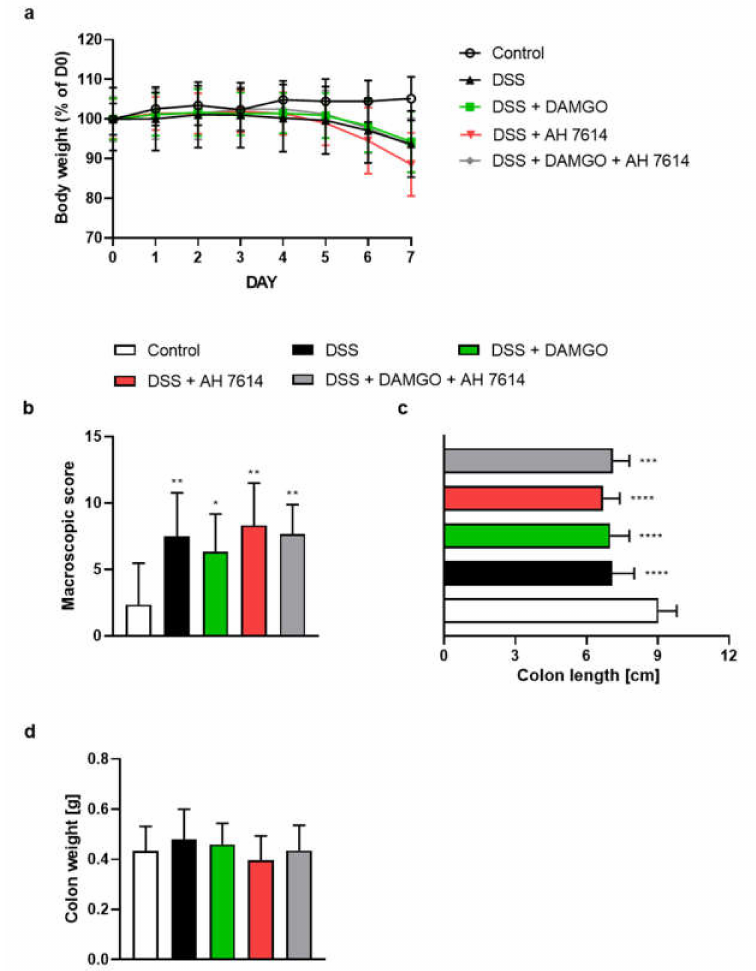
Figure 2. The i.p. administration of MOR agonist DAMGO (0.02 mg/kg BW) and FFAR4 antagonist AH 7614 (1 mg/kg BW) from day 3 to day 6, both twice daily did not alleviate symptoms of DSS- induced colitis in mice. Figure shows data for body weight loss ( a ), macroscopic score ( b ), colon length ( c ) and colon weight ( d ). * p < 0.05, ** p < 0.01, *** p < 0.001 and **** p < 0.0001 as compared to control mice. Data represent mean ± SEM of 5–10 mice per group. Abbreviations: DSS—dextran sulfate sodium, FFAR4—free fatty acid receptor type 4, i.p.—intraperitoneally, MOR— µ opioid receptor,